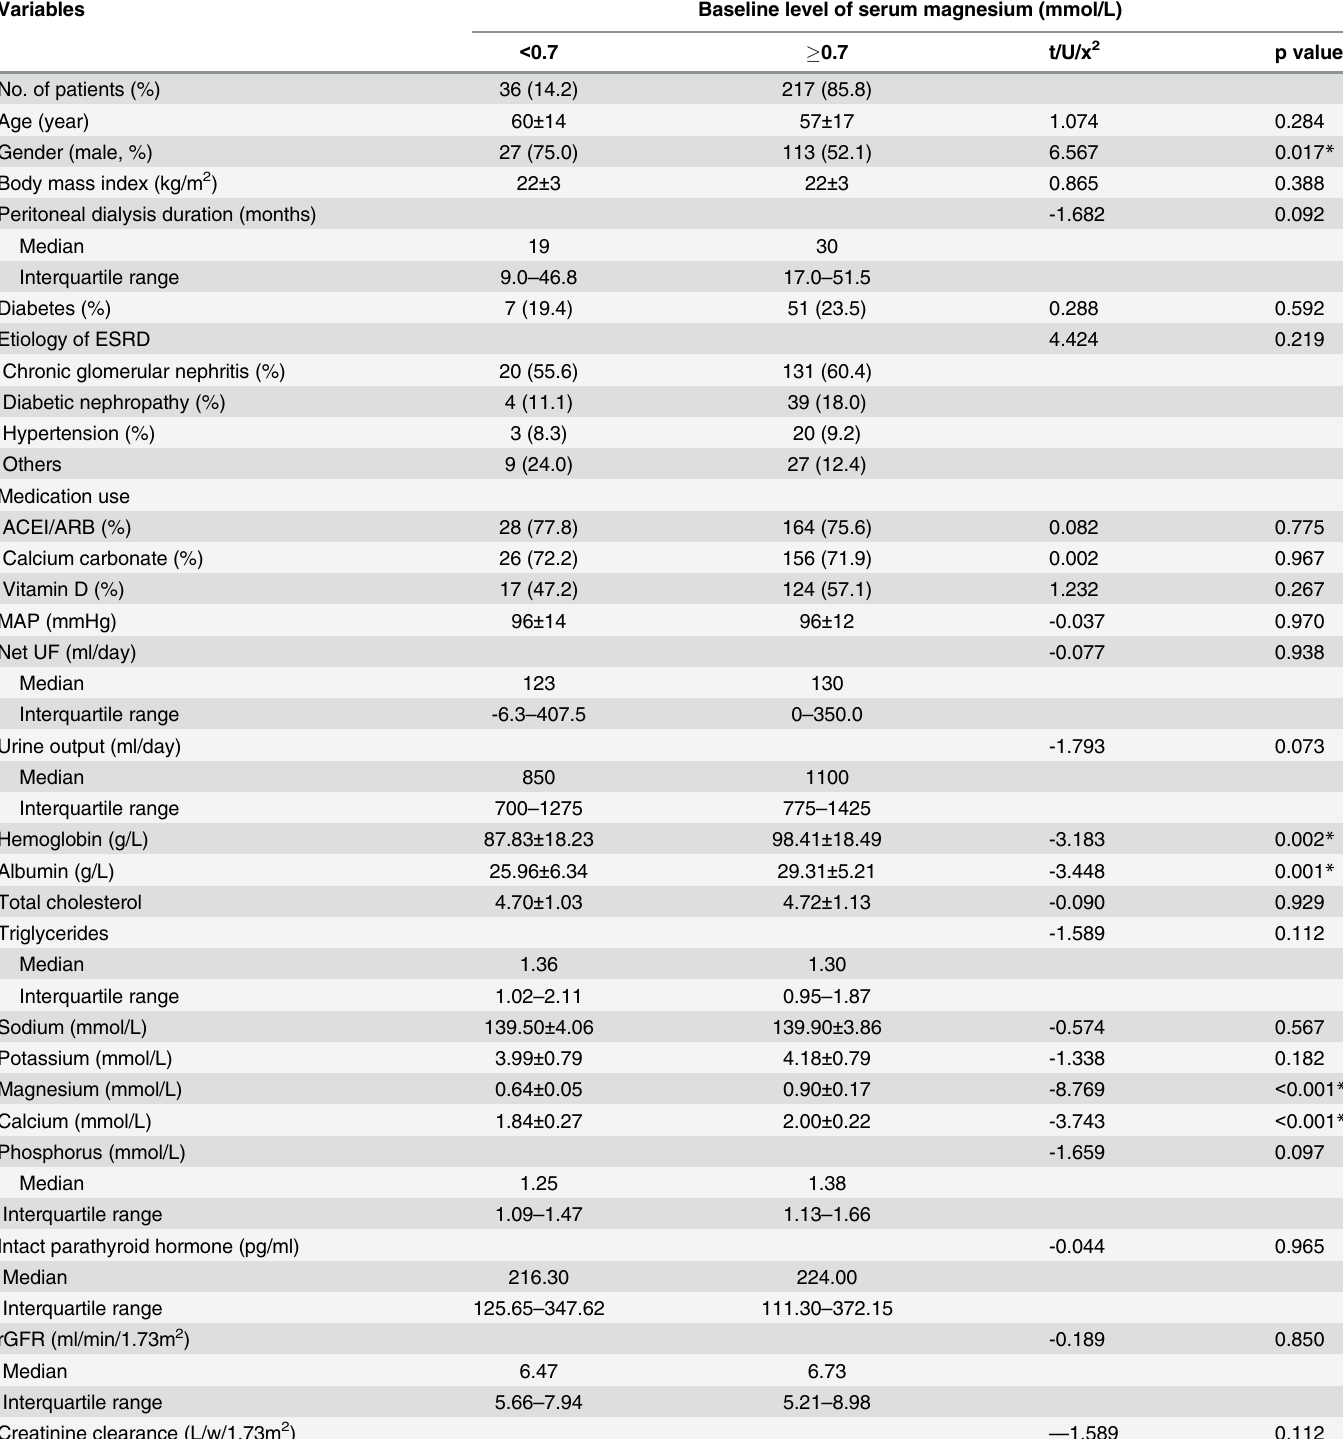
Table 1. Baseline demographic and clinical characteristics of PD patients stratified by baseline serum magnesium level (t/U/x 2 : different variables were compared using different methods: t-value for normally distributed variables, U-value for non-normally distributed variable, x 2 for categorical